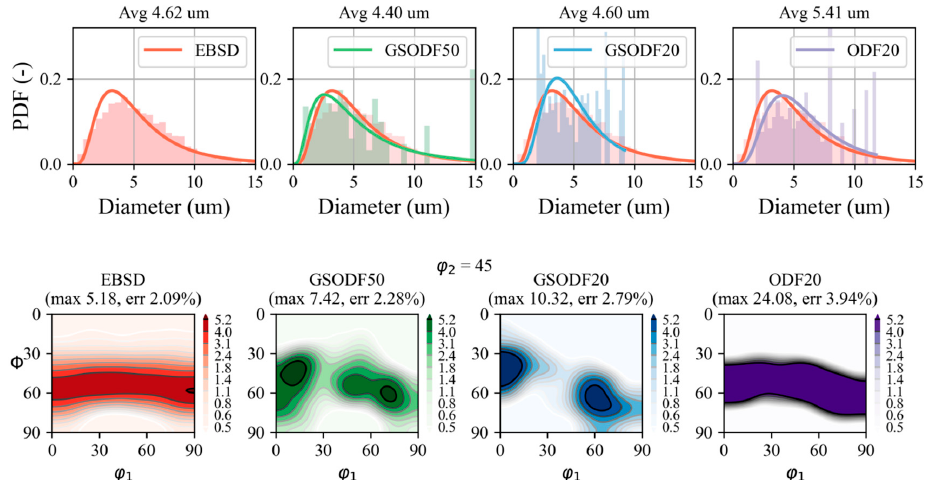
Figure 12. Obtained grain size distributions and crystallographic textures ( ϕ 2 = 45 ◦ sections) in EBSD experiments and DAMASK simulations. For each grain size distribution, the average grain size is shown on top. On top of the textures, it is shown which is the maximum value and the error with respect to the ODF calculated from the EBSD data, or between the calculated ODF and the raw data (see caption of Figure 6).